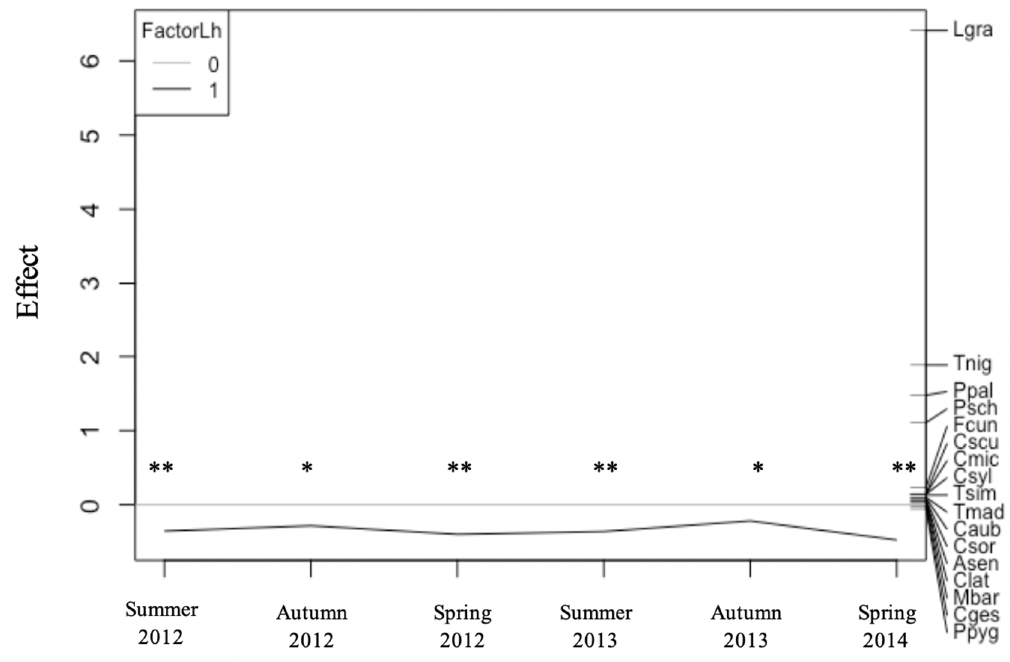
Figure 5. Principal response curves (PRC) representing the effects of the invasion by the Argentine ant on native ants foraging on citrus tree canopy. The left y axis represents deviances from the control (uninvaded orchards). Significant deviances based on Monte Carlo permutation tests are marked with one ( p < 0.05) or two asterisks ( p < 0.001). The right side of the figure represents ant species weight, accounting for the deviances of the PRC. The first axis explains 96% of the variance of species–environment. Legend: 0—native ant community (gray reference line); 1—ant community a ff ected by the Argentine ant invasion (black line); Lgra— Lasius grandis , Tnig— Tapinoma nigerrimum , Ppal— Pheidole pallidula